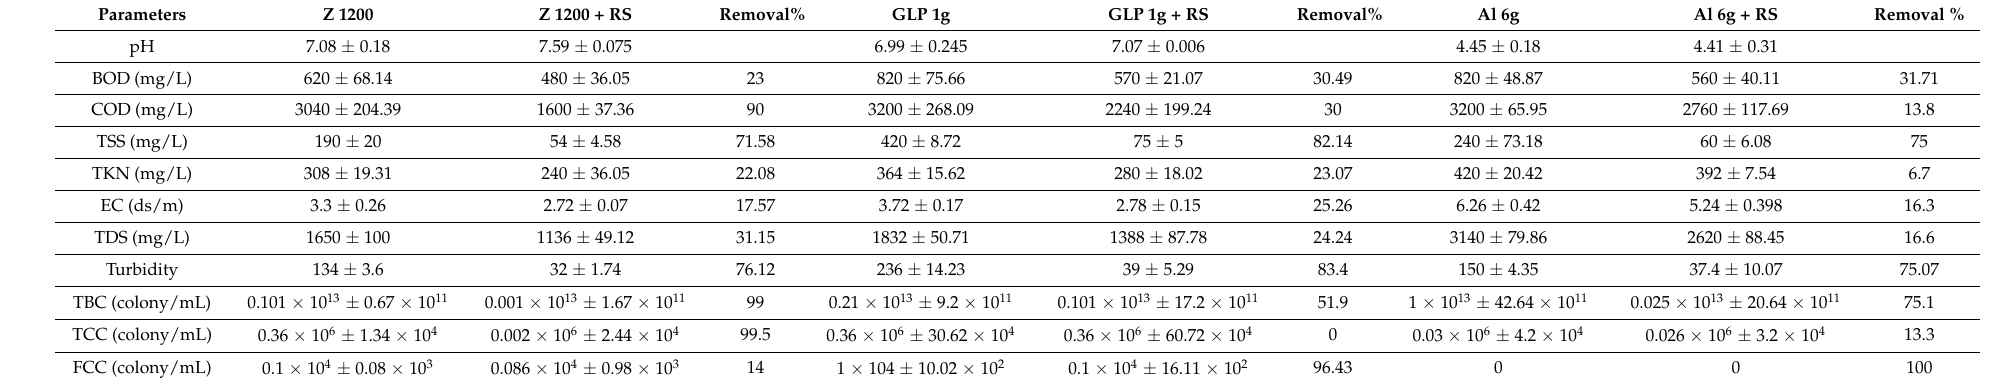
Table 5. Effect of filtration process with physically treated rice straw (RS) on the physicochemical and bacteriological characters of SHWW after coagulation with Z 1200 mg, GLP 1 g, and alum 6 g ( ±